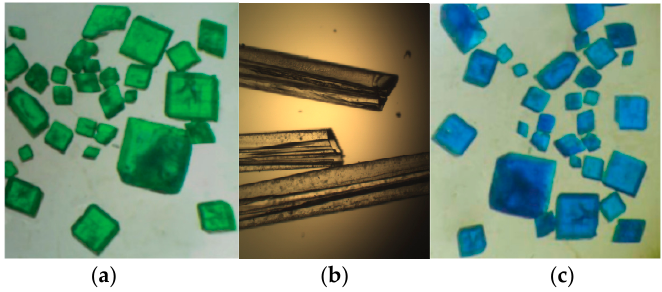
Figure 1. Images showing examples of single crystals of Ni ( a ), Cd ( b ), and Cu ( c ) coordination polymers generated hydrothermally.